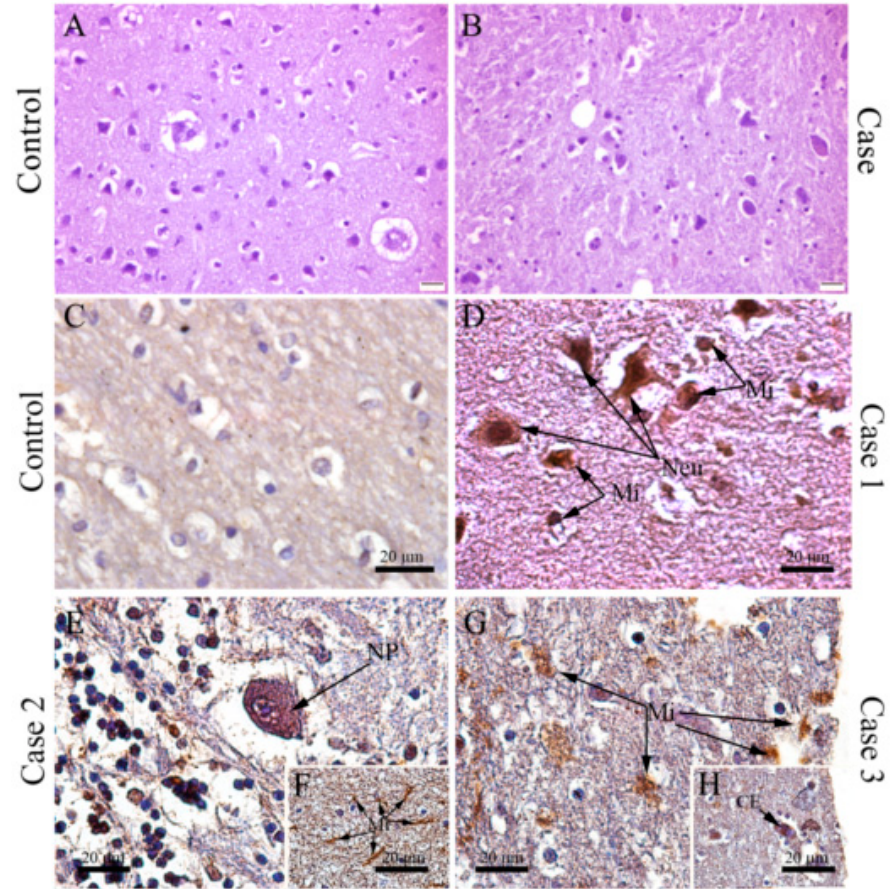
Figure 3. DENV antigen detection in the brain of fatal cases. ( A ) Brain tissue of a non-dengue case and ( B ) dengue case incubated only with secondary antibody; ( C ) Brain tissue of a non-dengue case incubated with primary and secondary antibodies; Detection of DENV antigen in: ( D ) neurons and microglial cells of case 1; ( E ) in Purkinje neurons ( F ) and microglia of case 2; ( G ) in microglia ( H ) and endothelial cells of case 3. Neu—Neuron, Mi—Microglia, EC—Endothelial cells, PN—Purkinje neuron.